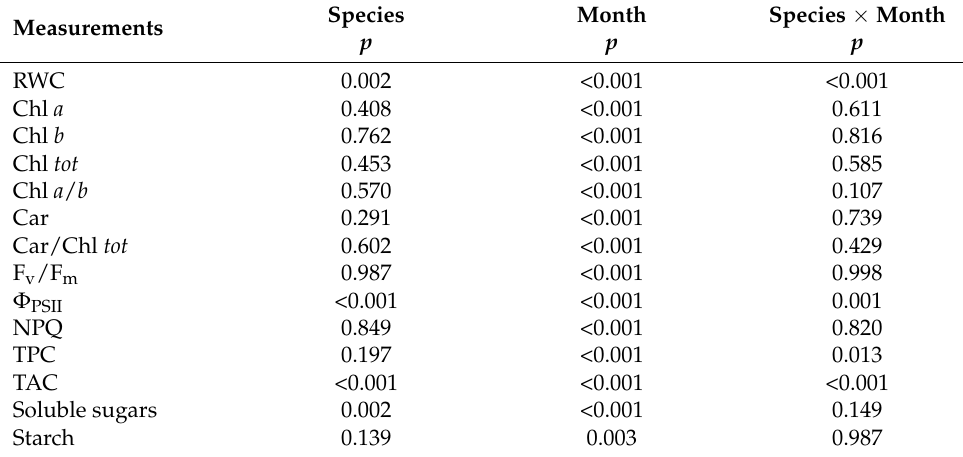
Table 3. Summary two-way ANOVA table for differences in relative water content (RWC),